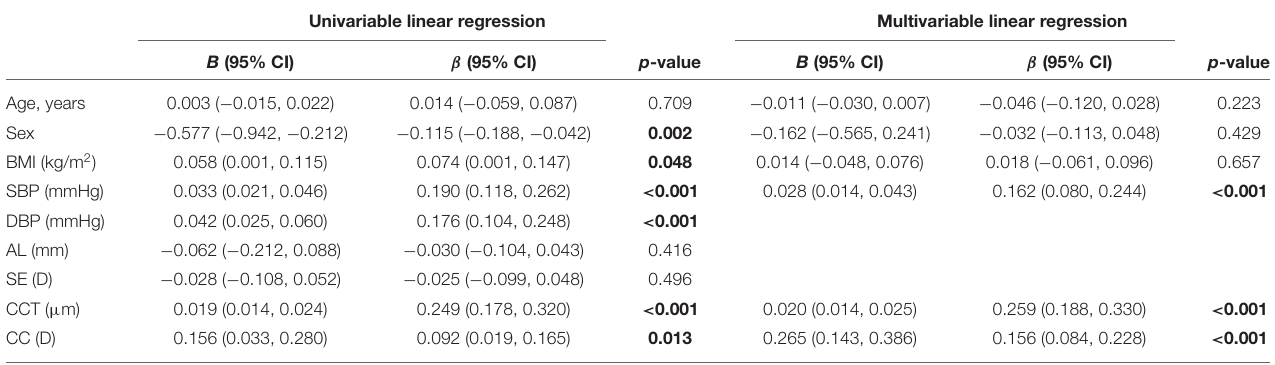
TABLE 3 | Univariate and multivariable linear regression analyses of factors that affect IOP GAT . Univariable linear regression Multivariable linear regression